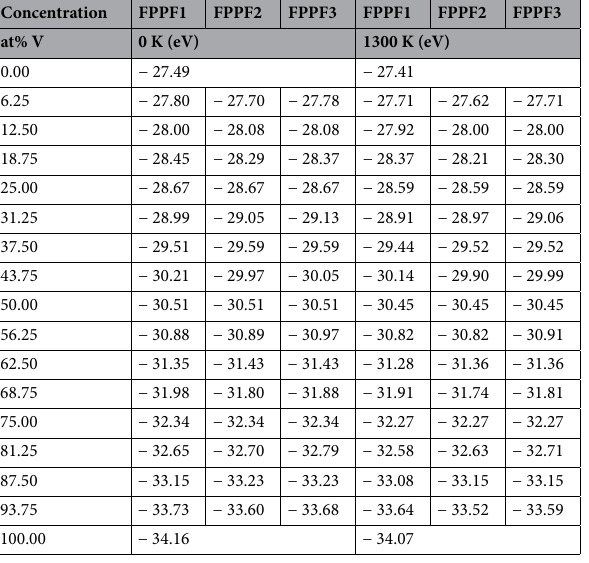
Table 2. Total free energy per four atoms obtained by the FPPF1, FPPF2, and FPPF3 simulations at each composition in units of eV. The energy values at 0 K are listed in the second to fourth columns, while the free energy values at 1300 K are listed in the last three columns.